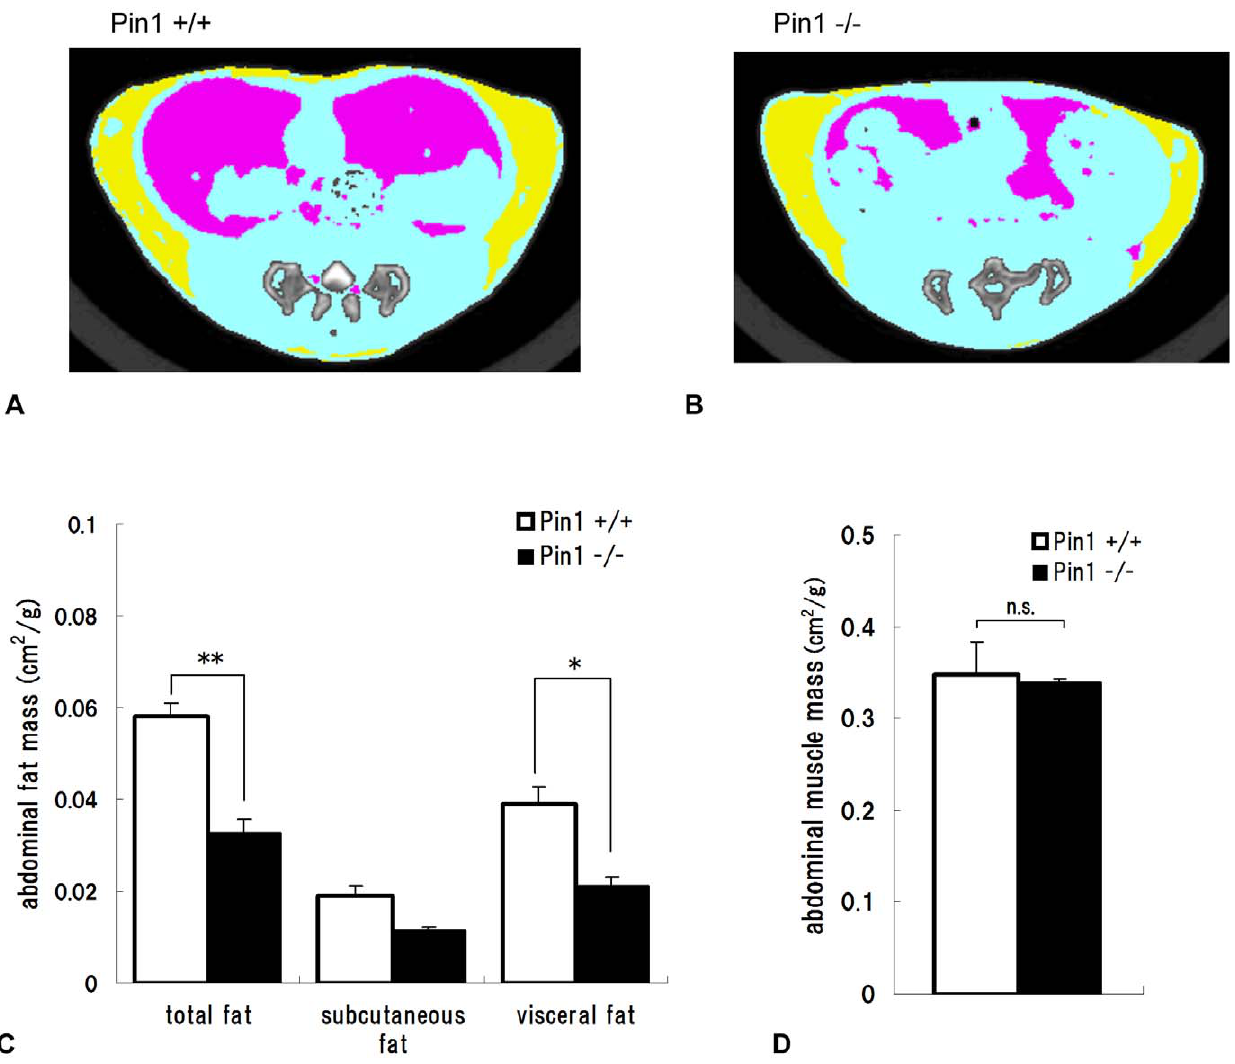
Figure 1. Computed Tomography analysis of wild-type and Pin1 2 / 2 mice. The abdomens of 16 week-old male wild-type (A) and Pin1 2 / 2 (B) mice were scanned (yellow; subcutaneous fat, pink; visceral fat, blue; muscle). Quantities of subcutaneous, visceral, and total adipose tissues (**p , 0.01) (C), and the other tissues, mainly muscle (D), were measured from the images. The areas were measured from the computer tomography images (cm 2 ) and they were adjusted for body weights of mice ( 6 SEM,